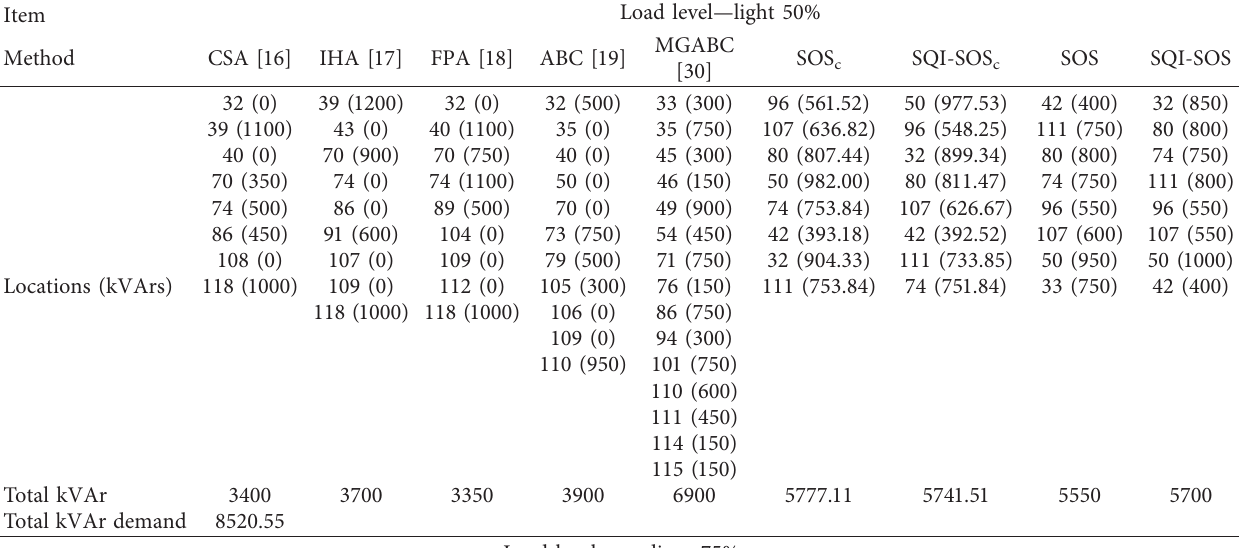
Table 14: Optimal siting and sizing of capacitors for the 119-bus system with the CP load model at different load